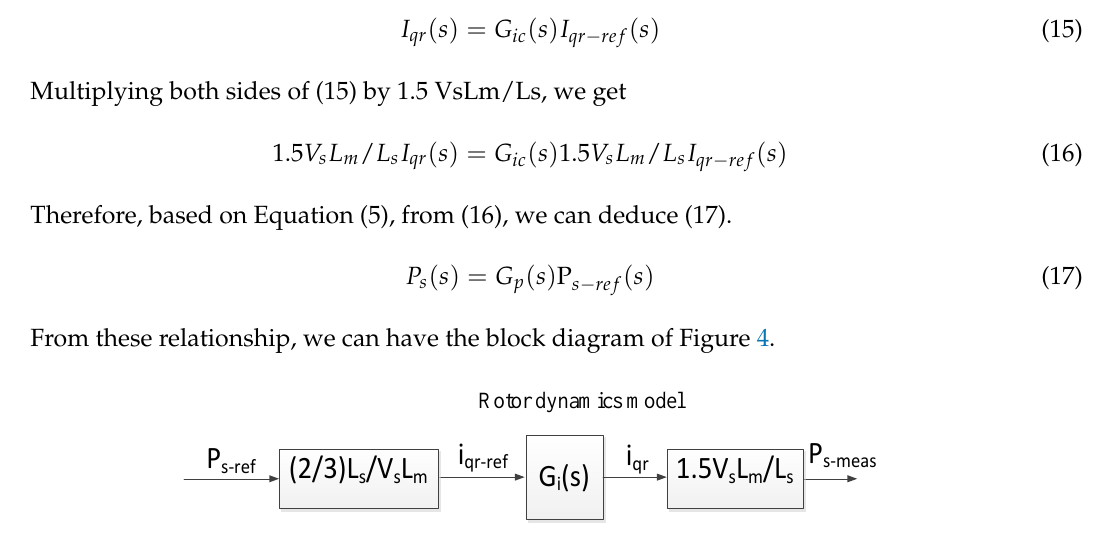
Figure 4. Control block diagram of the vector controlled DFIM for active power control